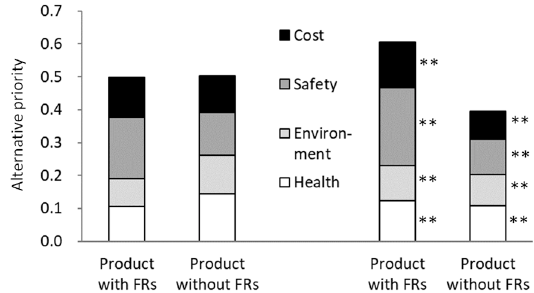
Figure 7. Priorities of product alternatives (left: before watching video; right: after watching video). Two-sided test, alternative hypothesis: “before watching video” ≠ “after watching video”, ** p < 0.01.